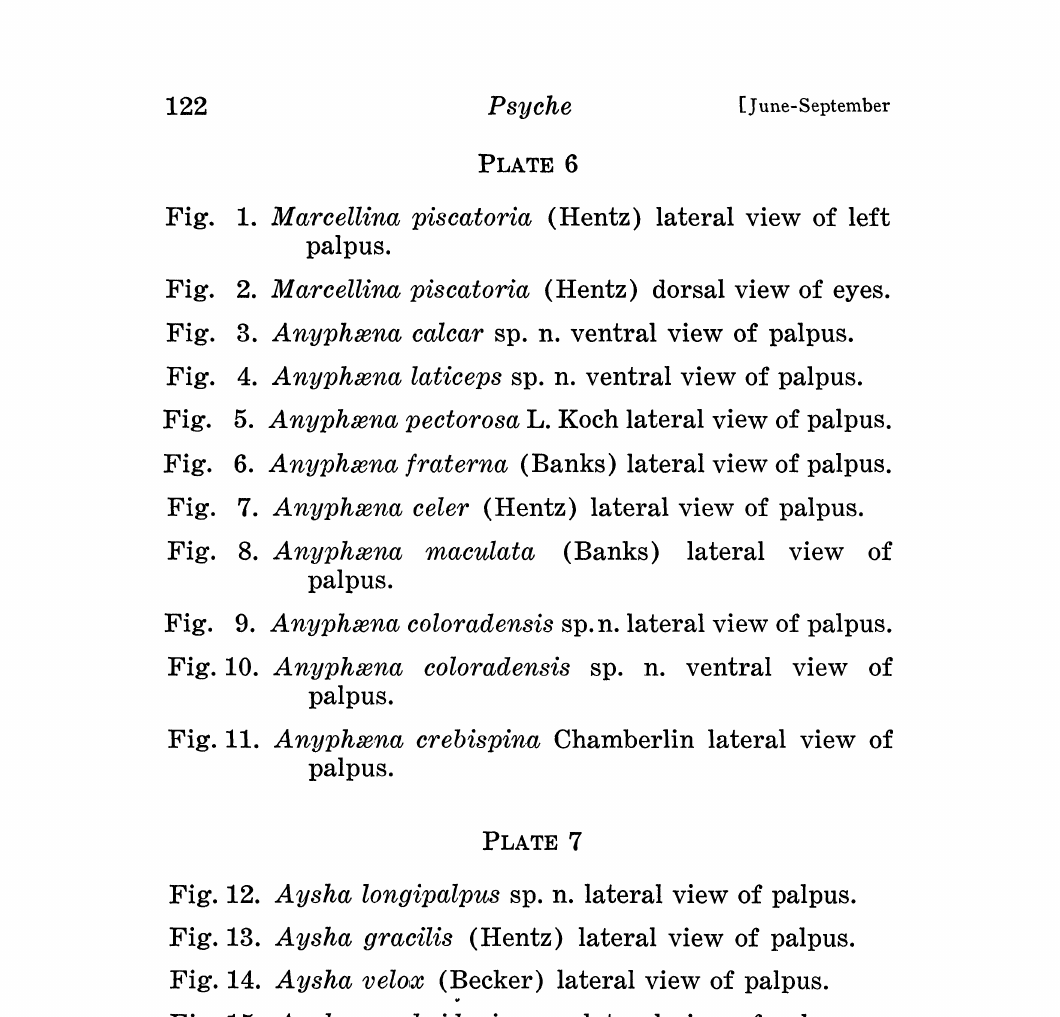
Fig. 19. Aysha tenuis (L. Koch) lateral view of palpus. Fig. 20. Anyphtenella alba (Hentz)